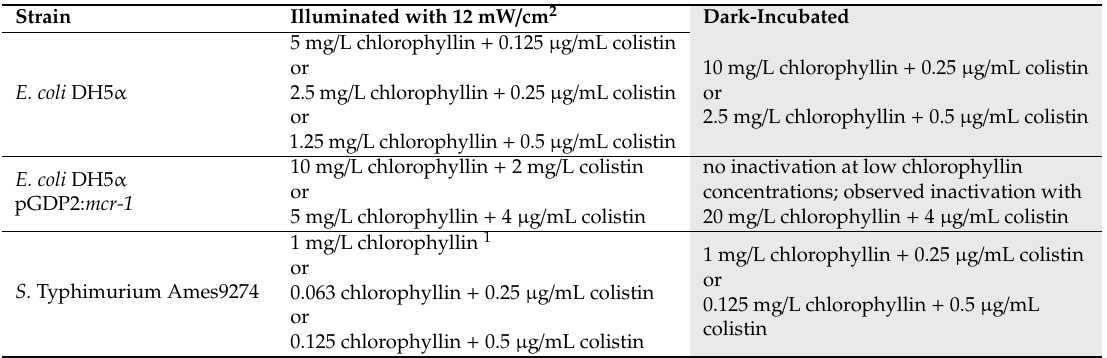
Table 1. Chlorophyllin-based inactivation of Gram-negative model strains. Strategies to inhibit cell growth in light (bright column) or darkness (grey